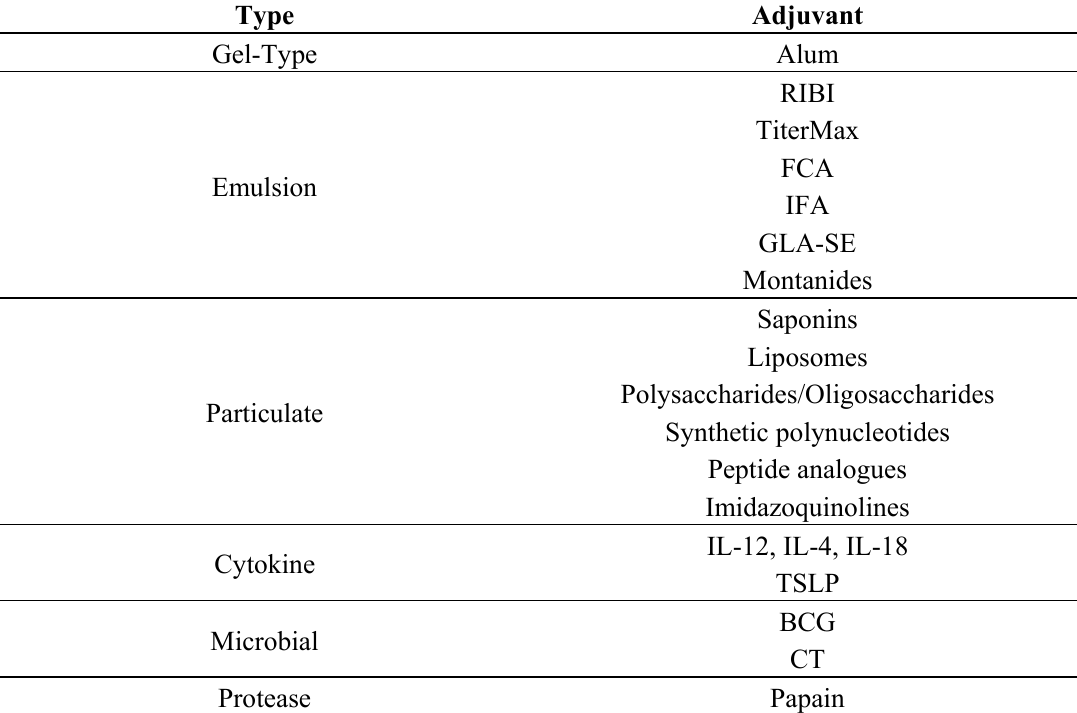
Table 1. Types of immunological